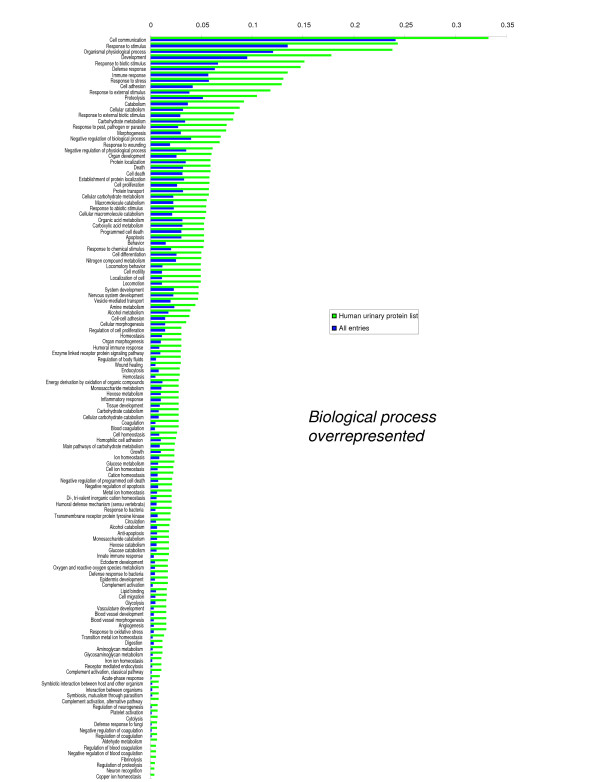
Significantly over-represented GO biological process terms for the set of identified urinary proteins. Each term was selected as described in the legend of Figure 6. GO, Gene Ontology.